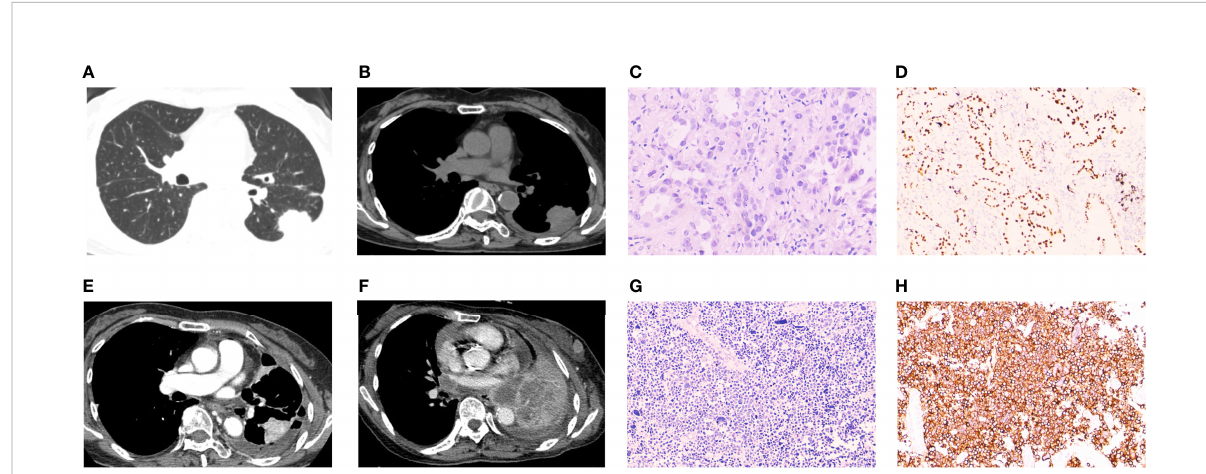
FIGURE 1 Radiographic and pathological images of Case 1. (A, B) A computed tomography (CT) scan at fi rst visit showing a left lung mass with lung window and mediastinum window. (C) Biopsy specimens of the left lung mass revealed malignant cells with adenoid structure, abundant cytoplasm, eosinophilic, and round nuclei, suggesting in fi ltrating adenocarcinoma of the left lung (H&E staining, ×200 magni fi cation). (D) Immunohistochemical (IHC) staining revealed transcription termination factor 1 (TTF-1) immunopositivity (TTF-1 staining, × 100 magni fi cation). (E) CT scan showing progression of left pulmonary lesions after 14 months of ge fi tinib use. (F) CT scan showed multiple nodules and masses in the left lung. The lesions were increased, enlarged and fused compared with 5 months ago. Multiple enlarged lymph nodes were seen, and multiple metastasis was considered. (G) Biopsy after mass resection revealed malignant cells, which were small, round, and arranged in small nests, with minimal cytoplasm and hyperchromic nuclei (H&E staining, ×200 magni fi cation). (H) IHC staining revealed diffuse strong positive expression of CD56 in cancer cells (CD56 staining, ×100 magni fi cation). Morphology and immunohistochemistry were consistent with small cell lung